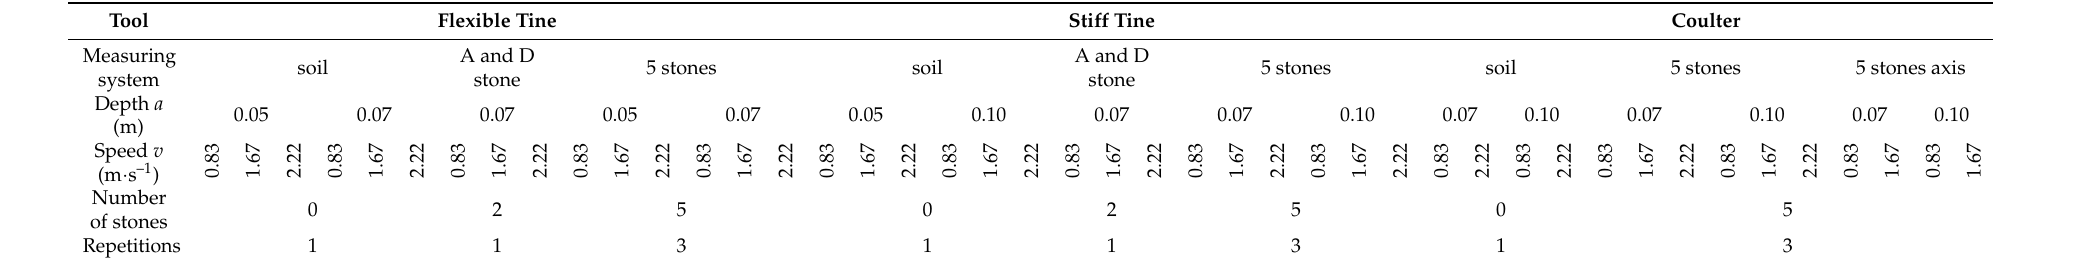
Table 3. Design of